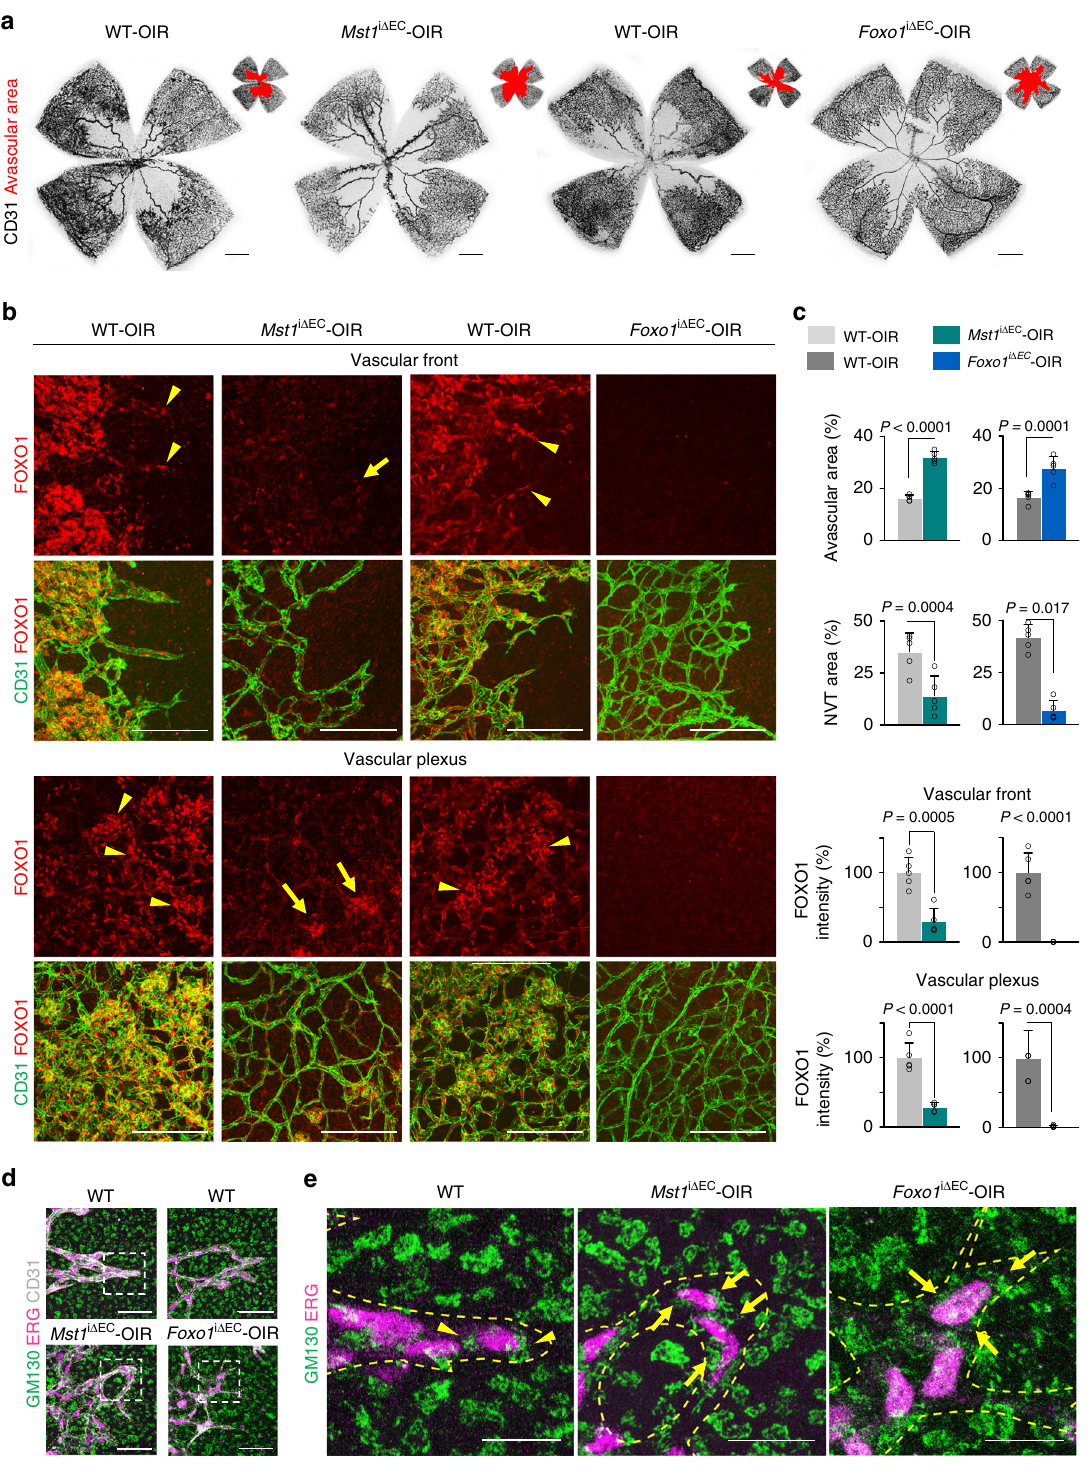
Generation of the anti-phospho-FOXO1 (Ser212) polyclonal antibody . The rabbit antibody against phospho-FOXO1 (Ser212) was generated as follows 13,19 . Brie fl y, the phosphopeptide antigen C-SAGWKNpSIRHNLS was synthesized, HPLC puri fi ed, conjugated to keyhole limpet hemocyanine, and injected into two rabbits over an 8-week period (one primary injection and three boosting injections) (Abclon). The antiserum was obtained for af fi nity puri fi cation to remove non- speci fi c antibodies, increase sensitivity and reduce background. Immunoblotting and immunoprecipitation assays . The cells were lysed on ice in RIPA lysis buffer supplemented with protease and phosphatase inhibitors